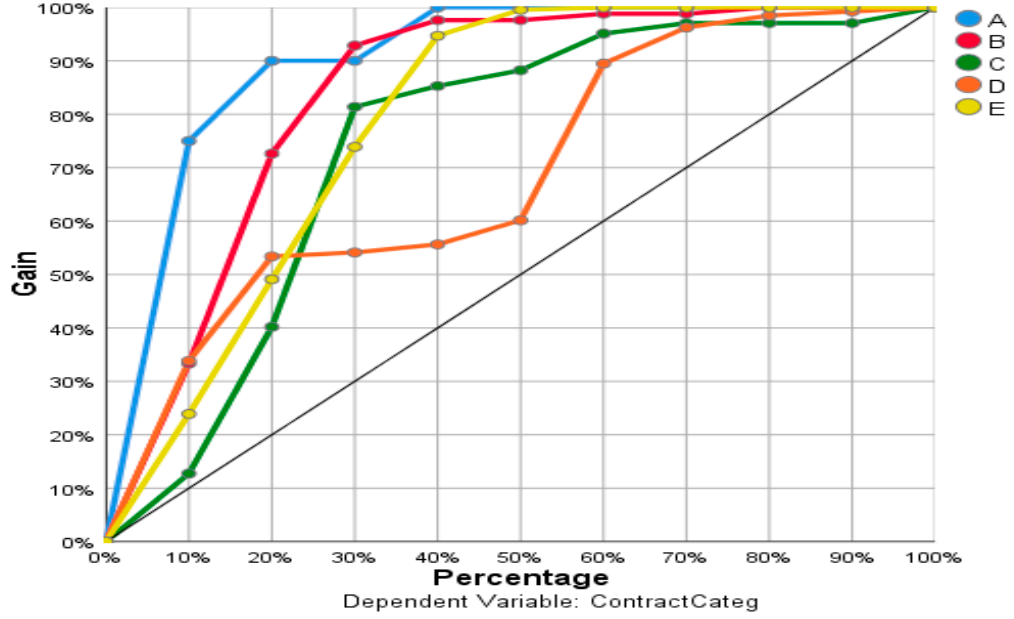
Figure 4. Cumulative gains chart for ContractCateg.